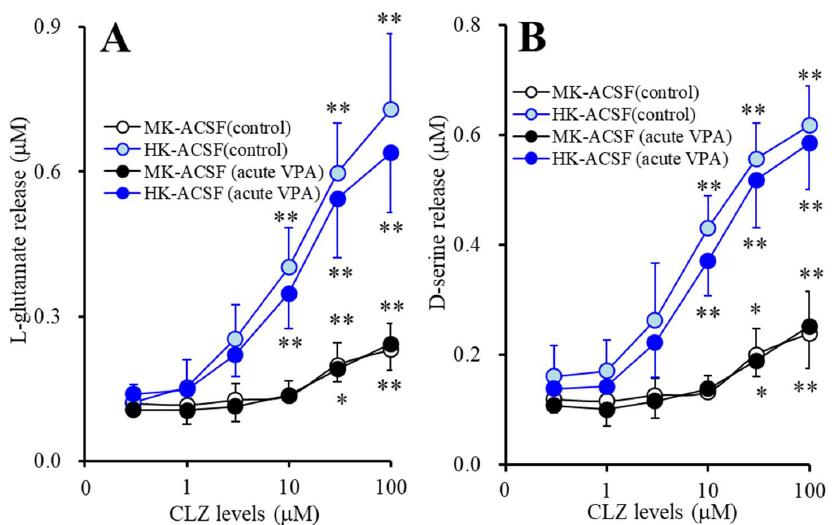
Figure 4. Acute effects of therapeutic-relevant concentration of VPA (1000 μ M) on astroglial releases of L-glutamate (A) and D-serine (D) from astrocytes subchronically administrated with CLZ. Astrocytes were incubated in fDMEM containing CLZ (0, 1, 3, 10, 30, or 100 μM) for 7 days. After wash-out, astrocytes were incubated in ACSF containing the same concentration of CLZ without (control: opened circles) or with therapeutic-relevant concentration of VPA (1000 μ M: closed circles) for 60 min (pretreatment incubation). After pretreatment, to determine the K + -evoked astroglial releases of L-glutamate and D-serine, astrocytes were incubated in MK-ACSF (50.0 mM K + : black circles) or HK-ACSF (100.0 mM K + : blue circles) containing the same concentrations of CLZ and VPA during pretreatment incubation for 20 min, and then incubate medium (MK-ACSF or HK-ACSF) was collected for analysis. Ordinate: mean ± SD ( n = 6) of extracellular levels of L -glutamate and D -serine (μM). Abscissa: concentration of CLZ ( μ M). * p < 0.05 and ** p < 0.01 vs. CLZ free by MANOVA with Tukey’s post hoc test.